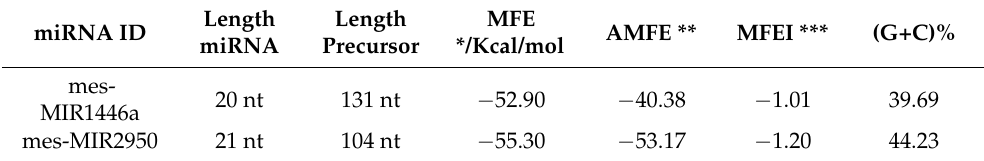
Table 6. The salient parameters of precursor cassava locus-derived mes-miRNAs were determined.